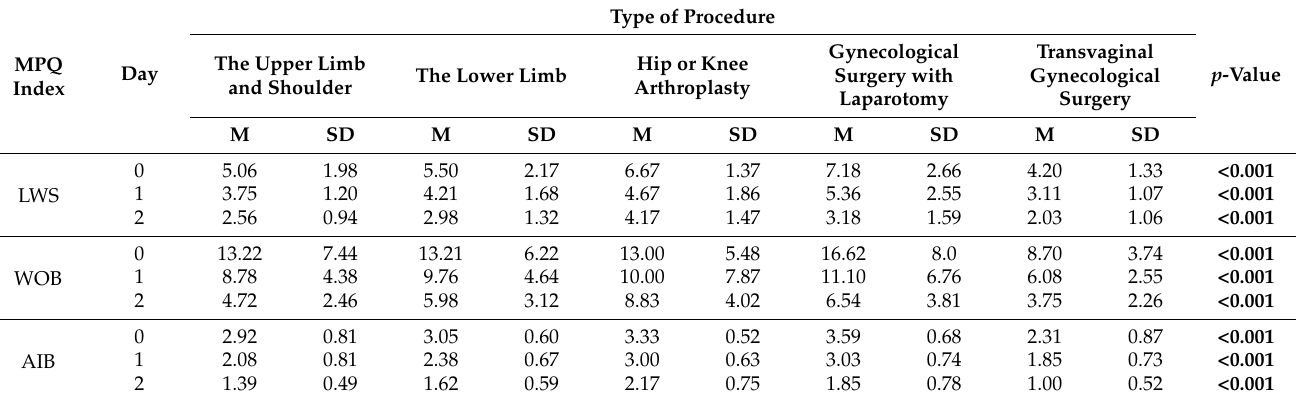
Table 7. The type of surgery and the intensity of postoperative